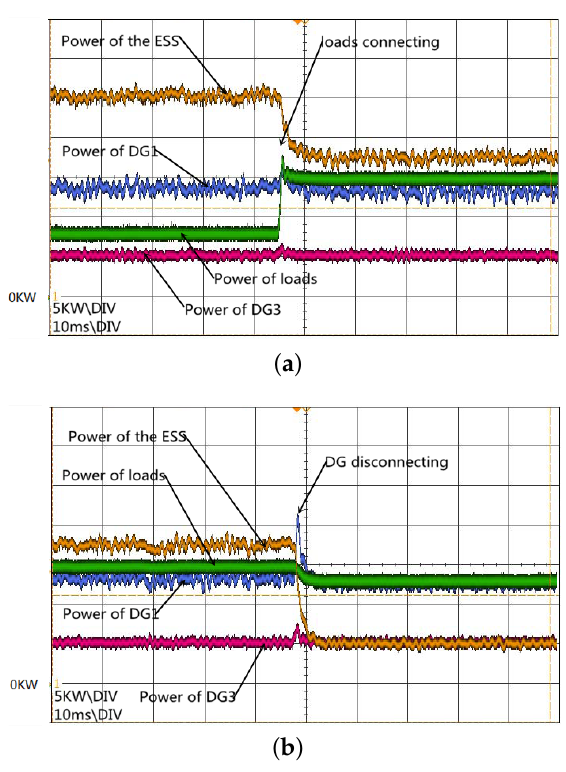
Figure 10. ( a ) Load connection and ( b ) DG disconnection of converters with feedback passivation.